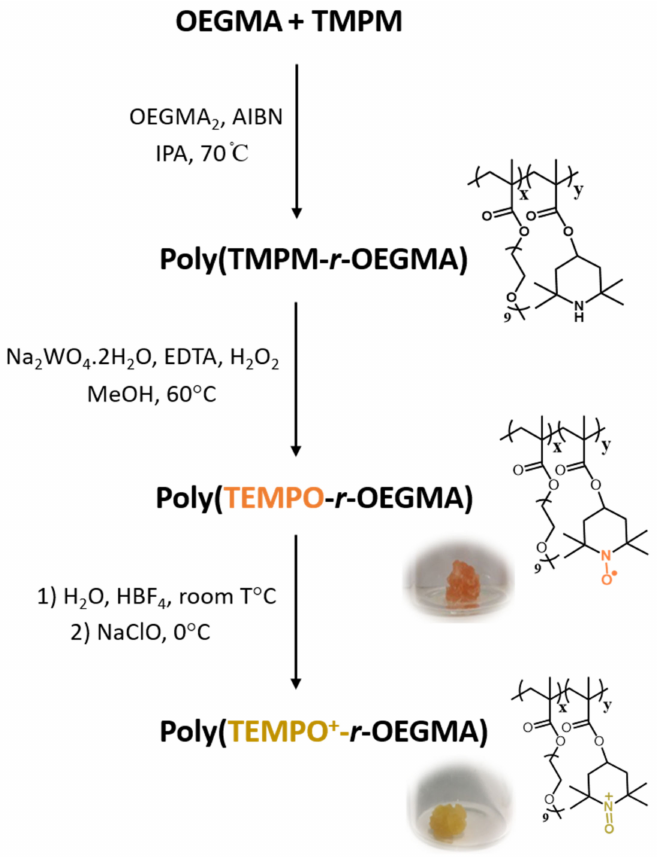
Figure 1. Synthesis of the poly(2,2,6,6-tetramethyl-1-piperidinyloxo ammonium methacrylate- random - oligo(ethylene glycol) methyl ether methacrylate) (P(TEMPO- r -OEGMA)) and oxidized P(TEMPO- r - OEGMA) (P(TEMPO + - r -OEGMA))